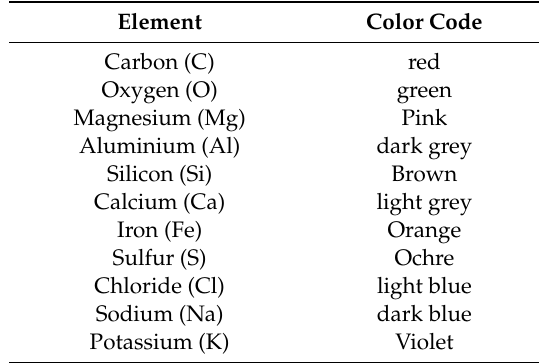
Figure 11. Left: BSE images of self-healing products of PC-4SF at di ff erent crack depth, Right: SEM-EDX line scan elemental analysis through the self-healing product. Line colors representing di ff erent elements according to Table 10. Table 10. Colors used to present the di ff erent elements in the line scan results of Figure